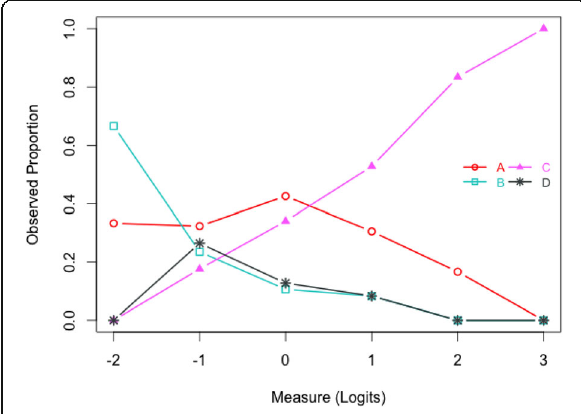
Fig. 2 Example distractor analysis plot. This figure shows an example of a distractor analysis plot for a multiple-choice item. The x -axis displays estimates of student achievement. Student achievement estimates are shown in logits, and these estimates were calculated using the Rasch model. Low values indicate lower achievement, and high values indicate higher achievement. The y -axis shows the observed proportion of responses for a given answer choice. The lines in the plot show the proportion of students who selected each of the four answer choices (A, B, C, or D) at each level of achievement. For this example item, the correct response is C (pink line with triangle plotting